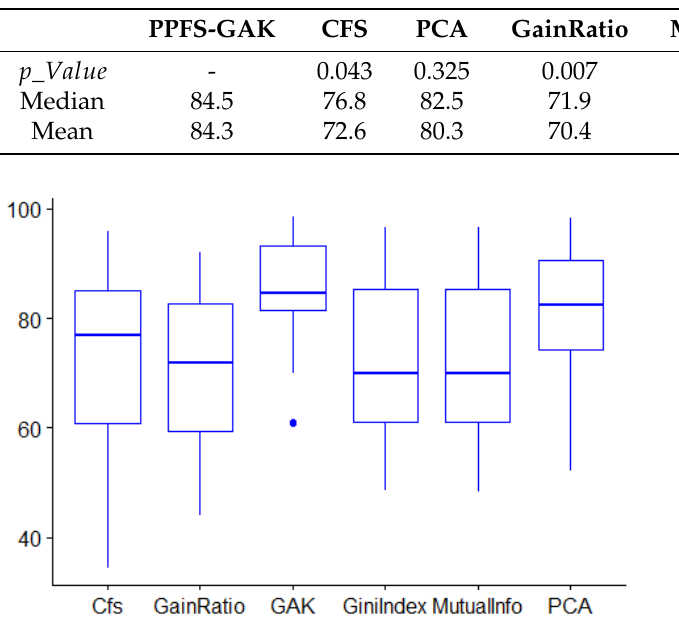
Table 8. The statistical test results of GAK and the 5 filter FS using 18 datasets.